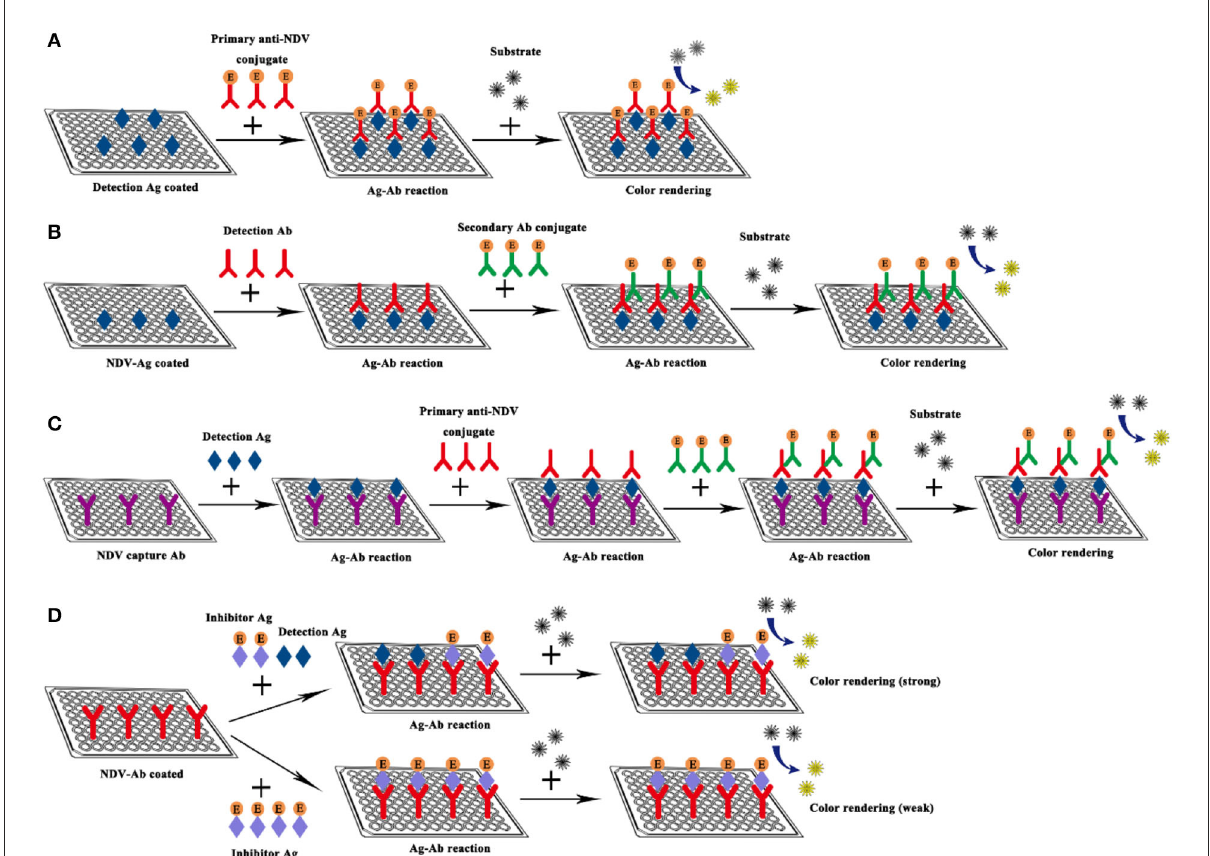
FIGURE5 Schematic diagram of NDV ELISA. (A) Direct ELISA; (B) Indirect ELISA; (C) Sandwich ELISA; (D) Competitive